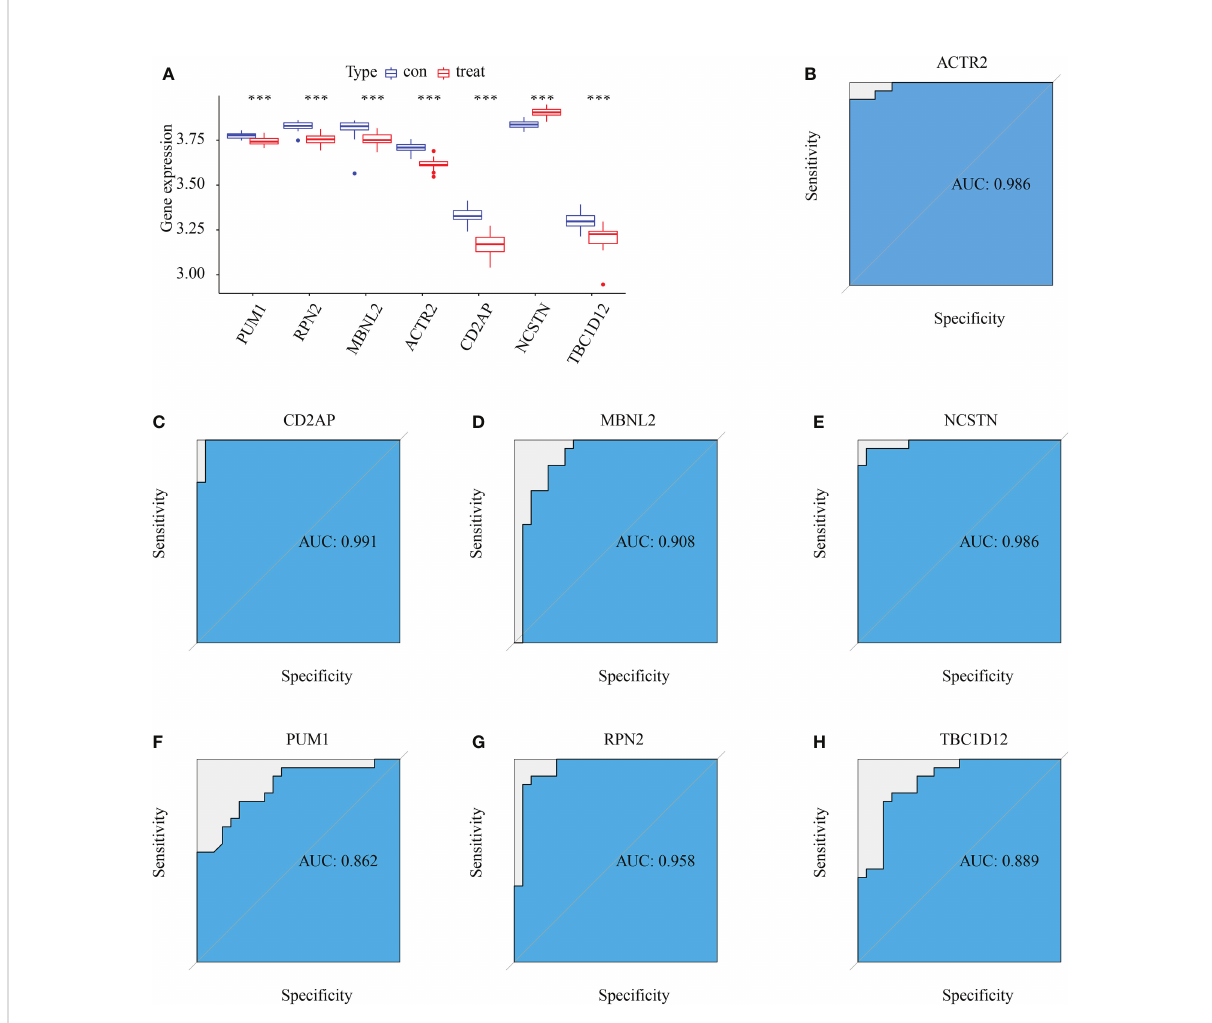
FIGURE 4 Diagnostic ef fi cacy of the target genes in the prediction of RM. (A) Box plots showing the mRNA expression of the target genes in stable and unstable atherosclerotic plaque specimens in the GSE165004 dataset. (B – H) ROC curves estimating the diagnostic performance of the target genes (B) ACTR2, (C) CD2AP, (D) MBNL2, (E) NCSTN, (F) PUM1, (G) RPN2 and (H) TBC1D12 in the prediction of atherosclerotic plaque progression in the combined GSE165004 datasets. ***p <